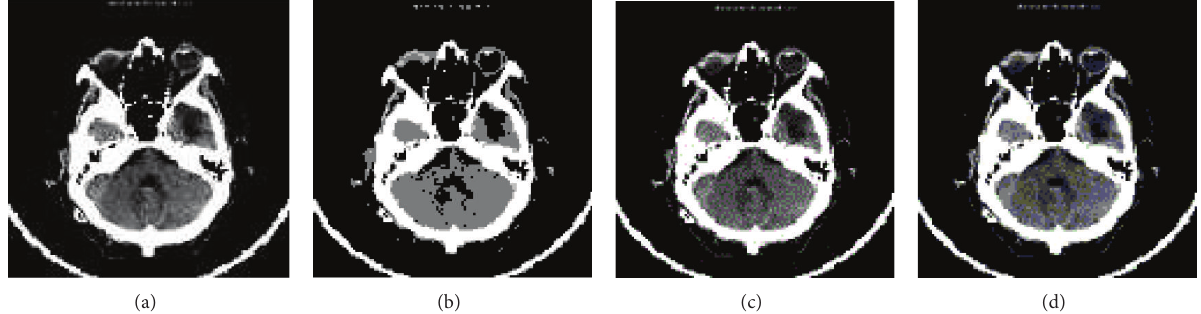
Figure 4: (a) Original processing sample Q1; (b) retrieved image using JPEG2000; (c) retrieved image using improved BPNN; (d) retrieved image using the proposed